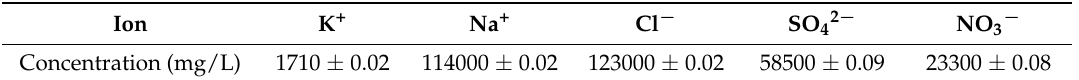
Table 1. Major ionic concentrations in the wastewater.